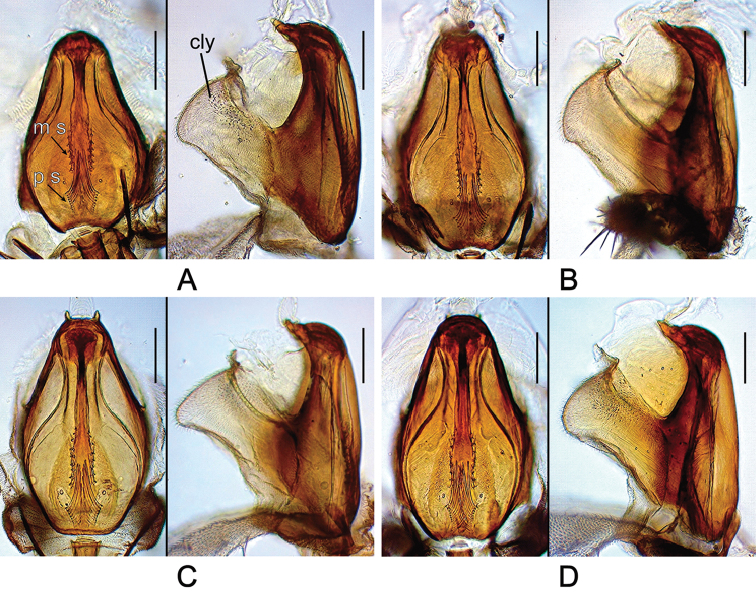
Cibarium of Dudaica species (part 1; dorsal and lateral views). Amalayana (Takada) (#03903) Bgracilipalpis sp. n. (paratype #00492) Cpuberula sp. n. (paratype #03366) Dalbipalpis sp. n. (holotype #03908). Abbreviations: cly = clypeus, m s = medial sensilla, p s = posterior sensilla. Scale bars: 0.1 mm.